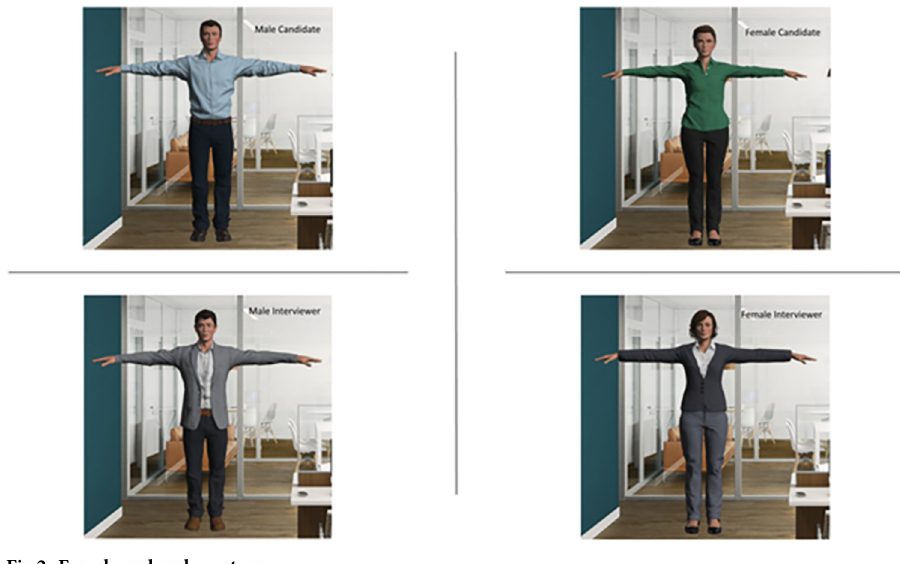
Fig 2. Female and male